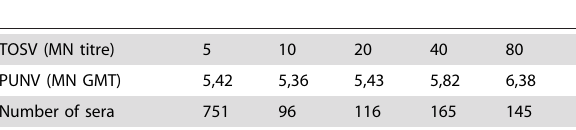
Table 4. Correlation between microneutralisation titre for Toscana Virus (TOSV MN titre) and microneutralisation geometric mean titre for Punique virus (PUNV MN